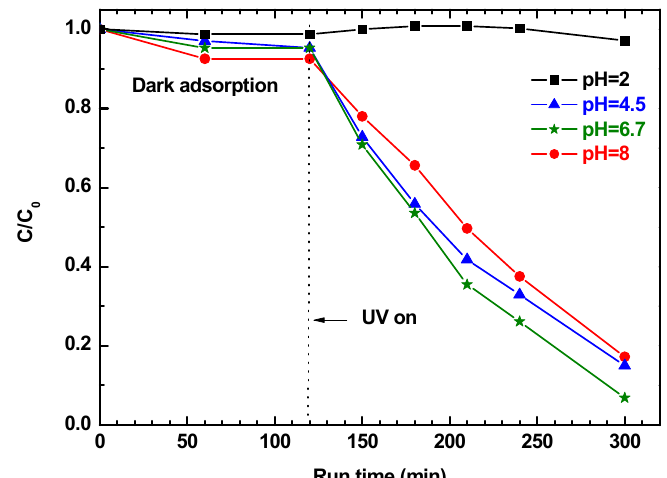
Figure 9. Phenol concentration in aqueous solutions, with pH in the range 2–8, treated with 2ZnO/s-PS δ -form aerogel.